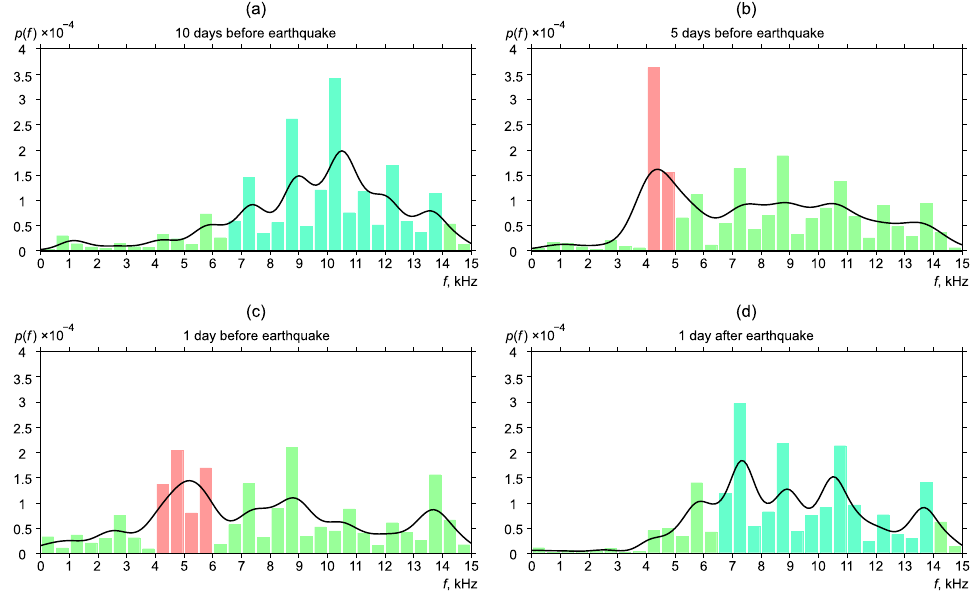
Figure 7. Dynamics of the probability density of distribution of the most powerful frequencies of geoacoustic pulses before and after the earthquake No.